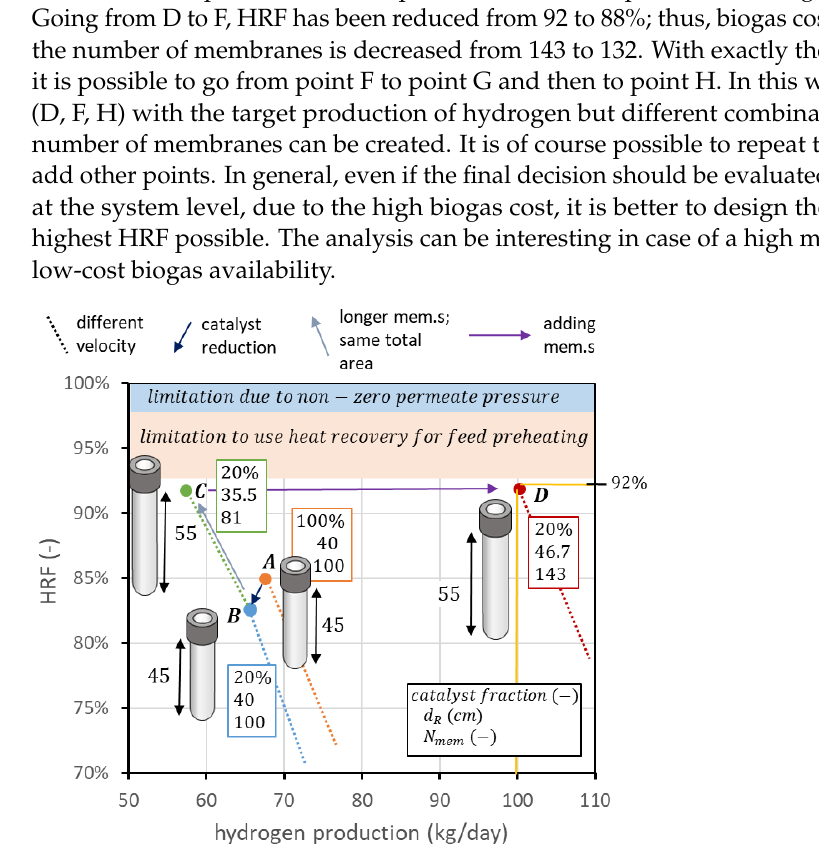
Figure 13. Design procedure to apply the knowledge from reactor analysis to move on the perfor- mance chart up to the desired combination of hydrogen production and HRF .